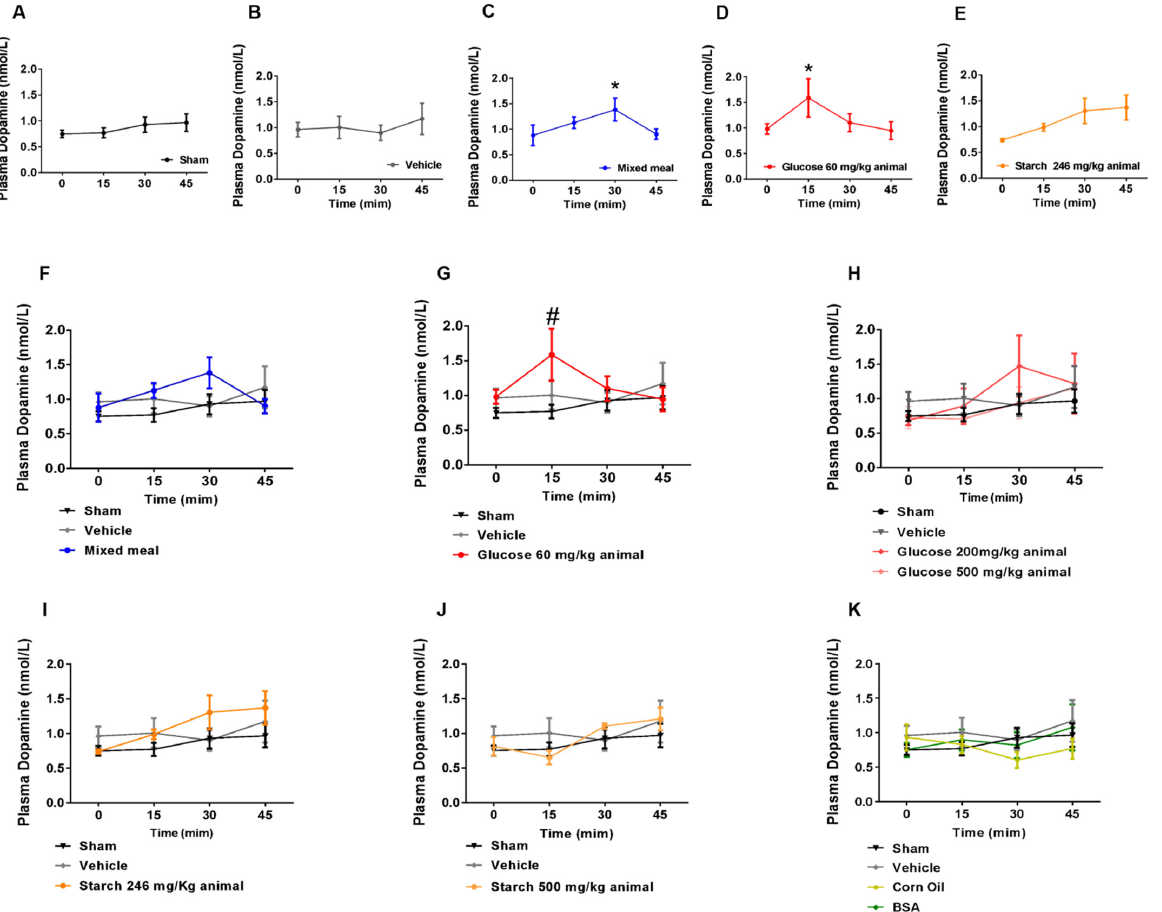
Figure 1. Postprandial dopamine excursions are modulated by gut carbohydrate sensing. Plasma dopamine excursions increased 30 min after mixed meal ingestion ( C ) and 15 min after glucose ingestion (60 mg/kg animal, ( D )), but not in sham ( A ) and vehicle ( B ) rats. Curves are compared in ( G ). Starch ingestion (246 mg/kg) triggered an increase in plasma dopamine level at 30 min which was maintained in time (45 min, ( E )), despite lacking a significant statistical result ( E , I ). Higher doses of ingested glucose (200 mg/kg or 500 mg/Kg) did not alter plasma dopamine excursions ( H ) nor did higher doses of starch (( J ), 500 mg/Kg). Albumin, arginine, and oil did not elicit plasma dopamine fluctuations ( K ). Bars represent means ± SEM. Differences between groups were assessed through the One-way ANOVA repeated measures test with Tukey multiple comparisons were used to analyze plasma dopamine levels throughout time (data plots ( A ) to ( E )). One-way ANOVA test with Tukey multiple comparisons was used to analyze plasma dopamine levels between groups at each time point (data plots ( F ) to ( K )). * Differences in time (data plots ( A ) to ( E )); # different from Sham and Vehicle groups. Levels of significance: 1 symbol, p < 0.05; 2 symbols, p < 0.01; 3 symbols, p < 0.001. Close to half of the dopamine levels in the organism are suspected to come from the gut since TH expression and activity are robust in mesenteric organs [13]. To disclose the gut’s involvement in postprandial dopamine secretion and action in adipose tissue, we performed sleeve gastrectomy, a restrictive surgical procedure that alters gastric chyme flow, in obese type 2 diabetic GK rats (Figure 2A). Unexpectedly, we found that TH levels were not altered in GKHCD_SL rats (Figure 2B), and neither were plasma dopamine levels upon mixed meal ingestion (Figures 2D,H). At 6-months-old, Wistar rats presented